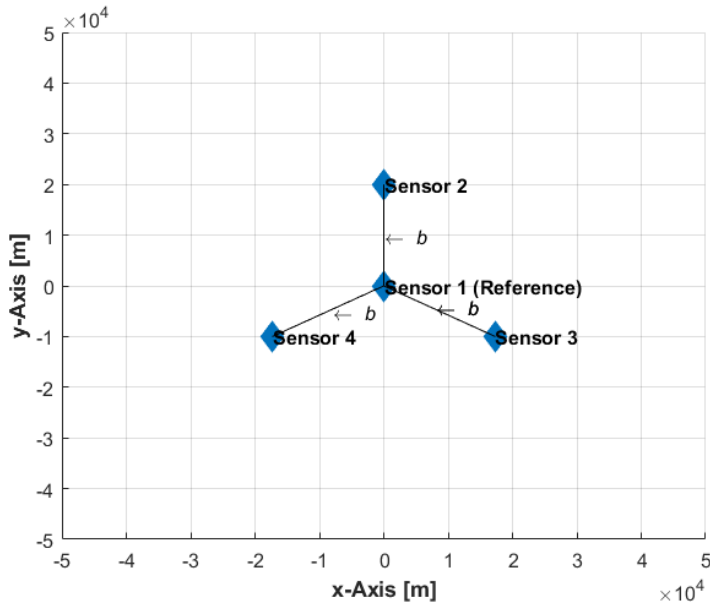
Figure 4. Formation of the sensors at the instant of measurements.